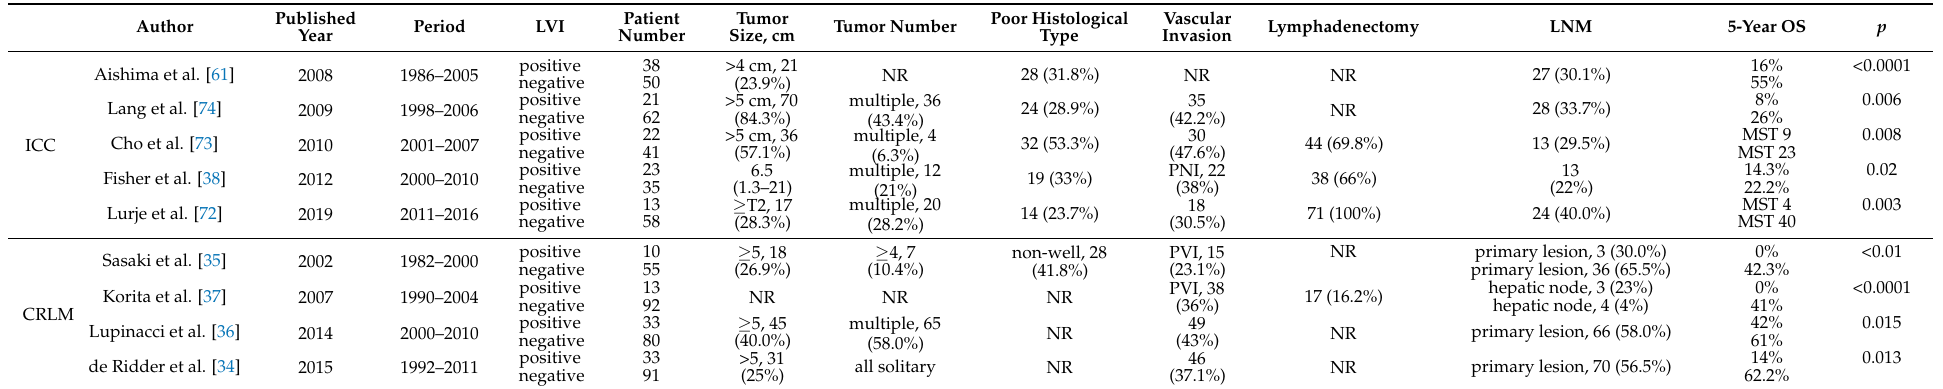
Table 2. Studies evaluating lymphatic vessel invasion in liver